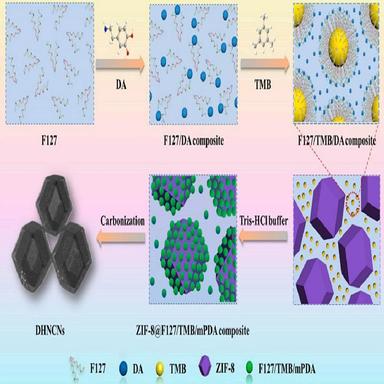
Schematic illustration of synthesis procedure of the DHNCNs.